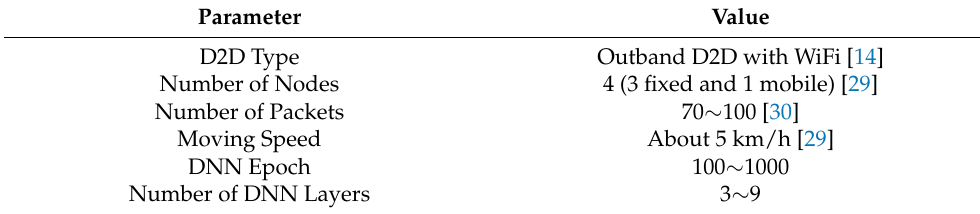
Table 1. Simulation